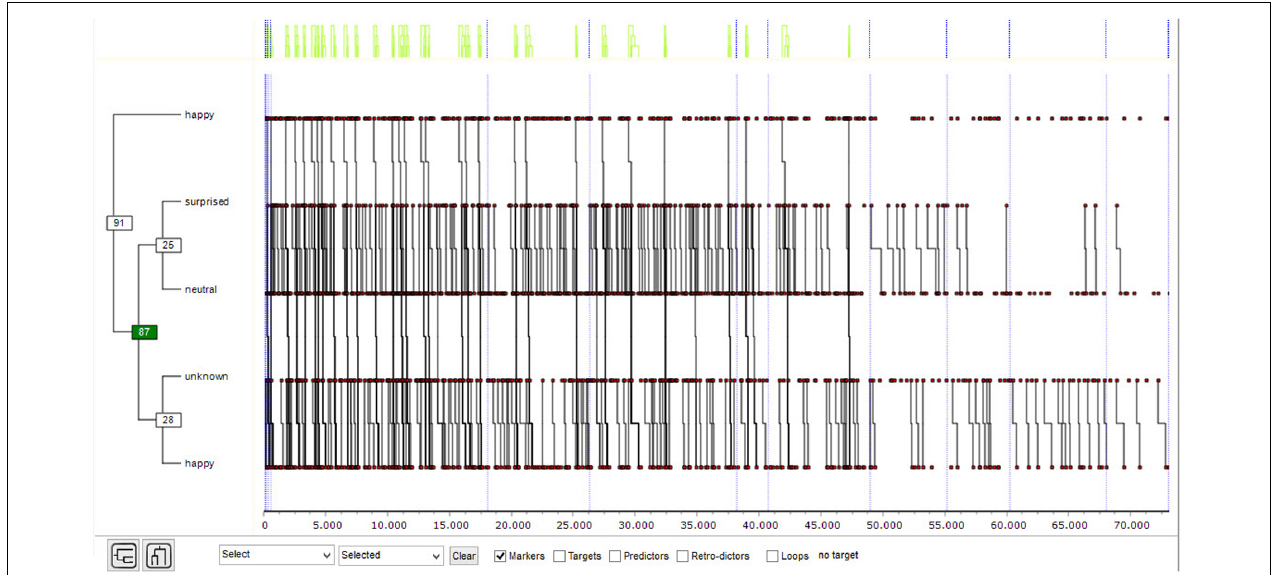
FIGURE 1 | T-pattern 1 for girls (significance level = 0.005; minimum number of occurrences = 30).